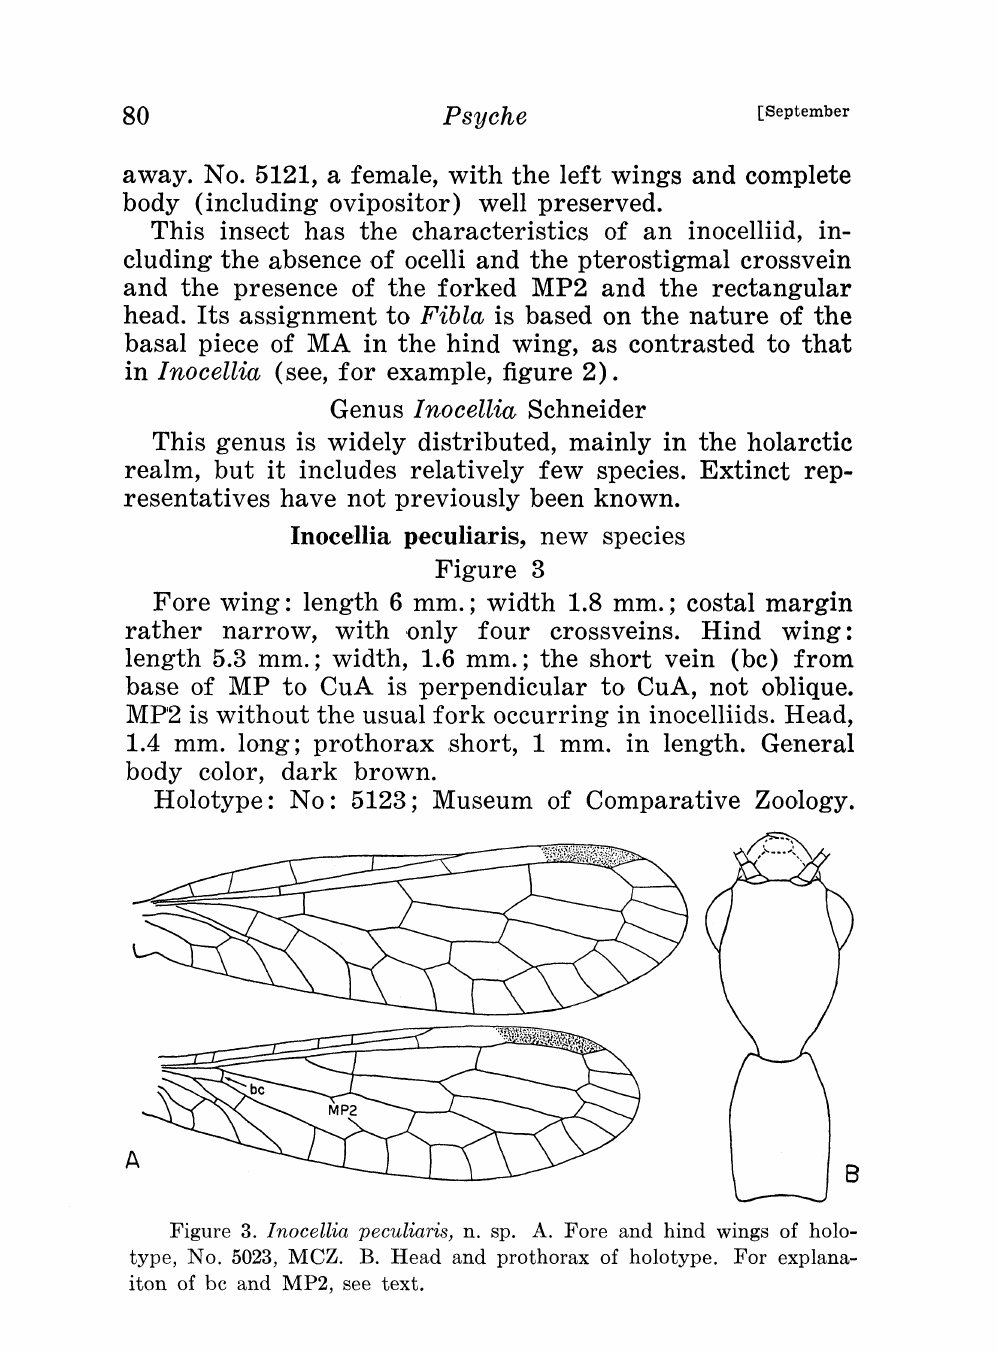
Figure 3. Inocellia peculiaris, n. sp. A. Fore and hind wings of holo- type, No. 5023, MCZ. B. Head and prothorax of holotype. For explana- iron of bc and MP2, see